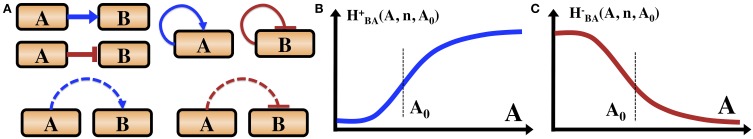
Introduction of the gene circuit notations. (A) Transcription and phosphorylation regulations. Blue arrows indicate transcription activation. Red bars indicate transcription inhibition. Dashed blue arrows indicate phosphorylation. Dashed red bars indicate dephosphorylation. We also illustrate that a gene can be self-activator or self-inhibitor. Some proteins can auto-phosphorylate (not shown here). (B) The functional form of an excitatory Hill function describing the action of an activator TF as is defined in the text. (C) The shape of an inhibitory Hill function describing the action of a repressor TF as is defined in the text.